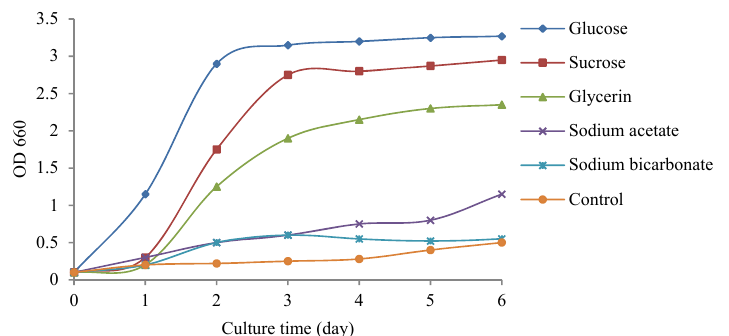
Fig. 1: The effect of different carbon sources on biomass Chlorella vulgaris (Kong et al ., 2011)